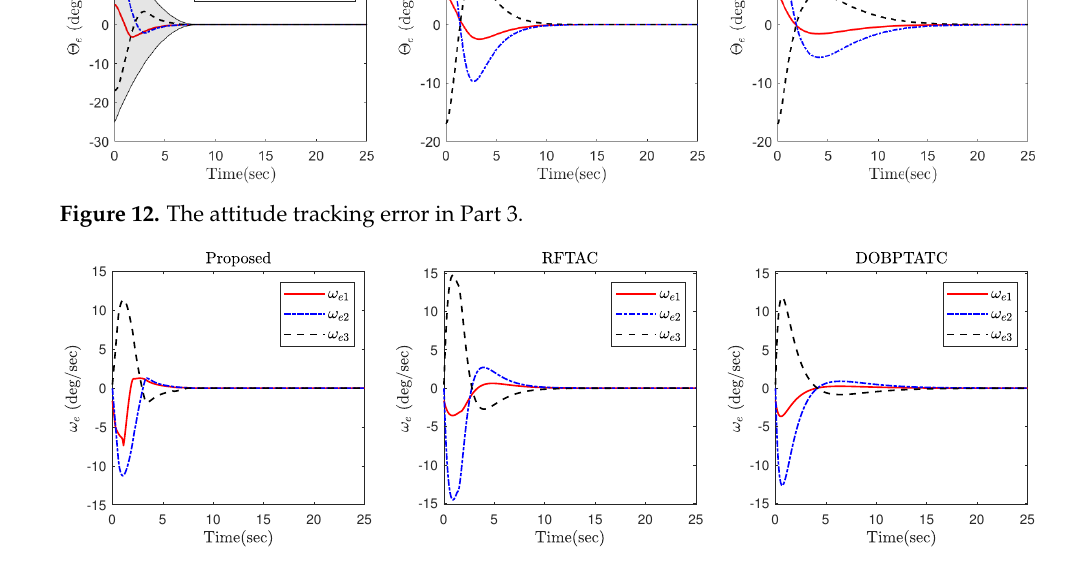
Figure 13. The angular velocity tracking error in Part